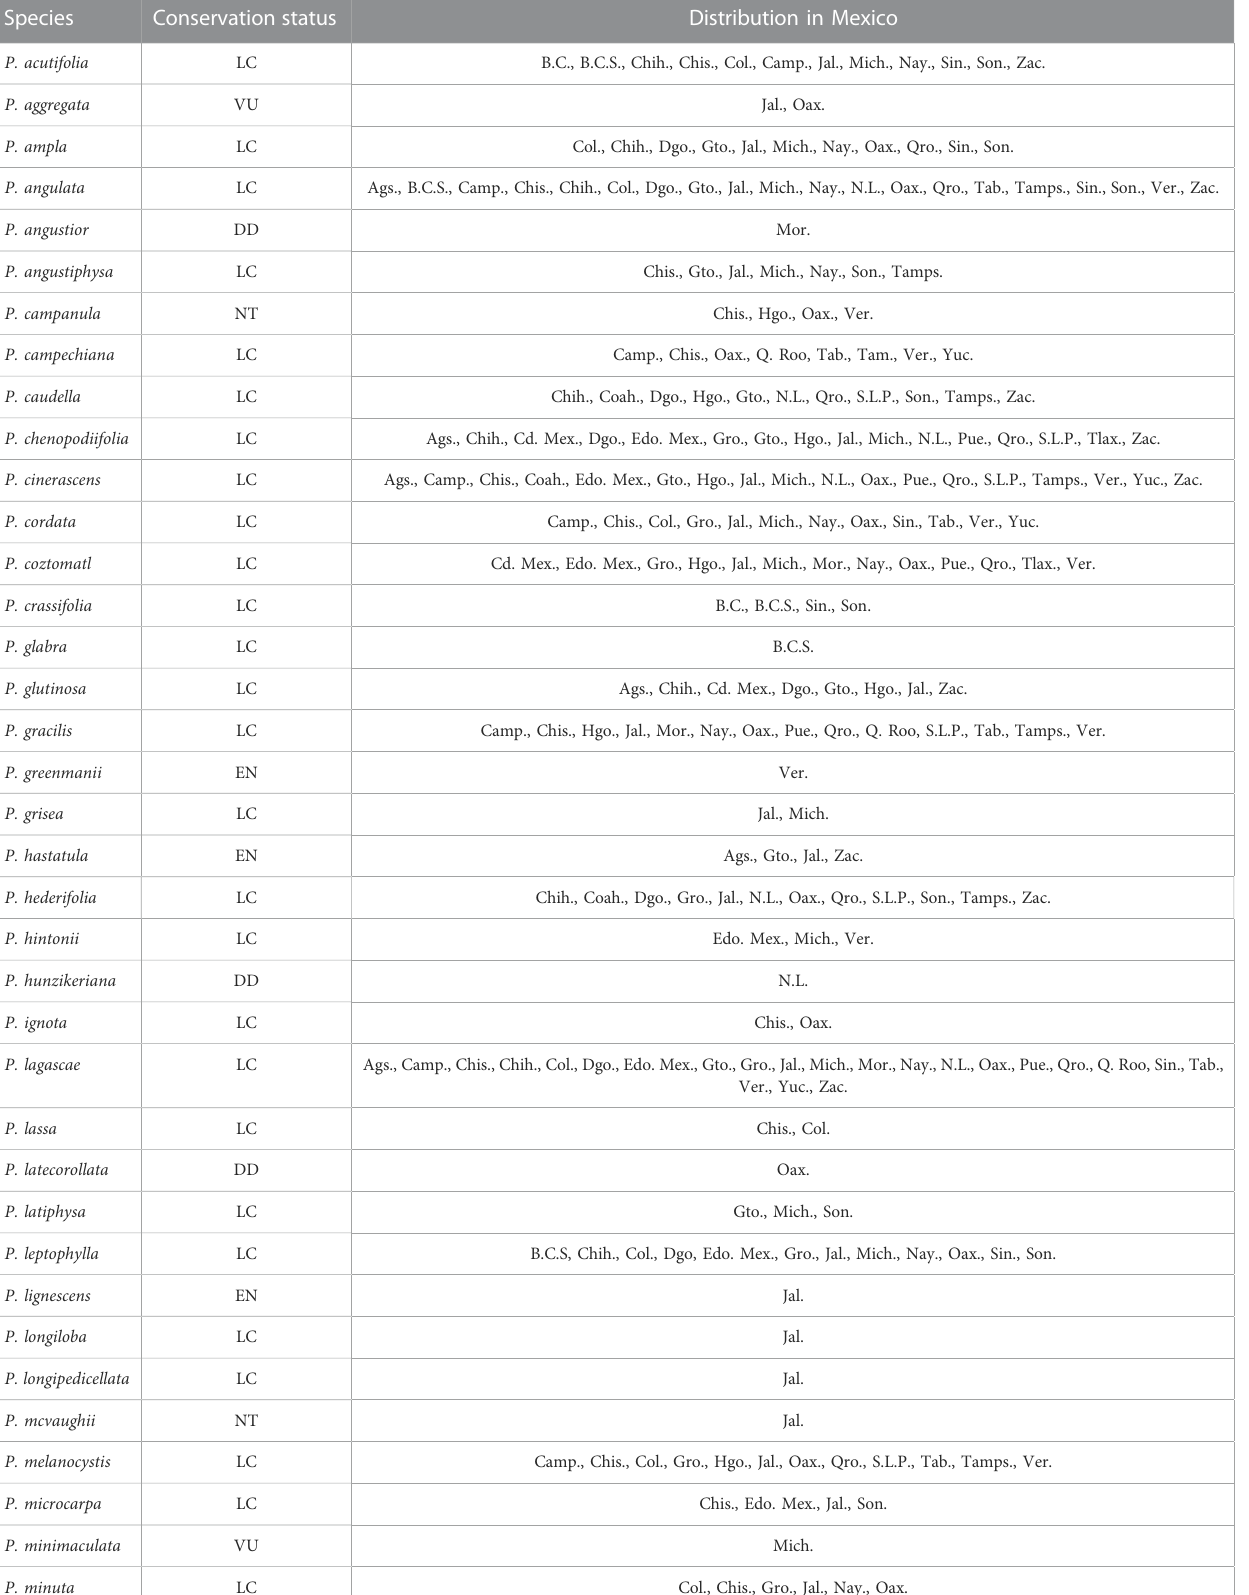
TABLE 1 Species distribution and conservation status of Physalis in Mexico.